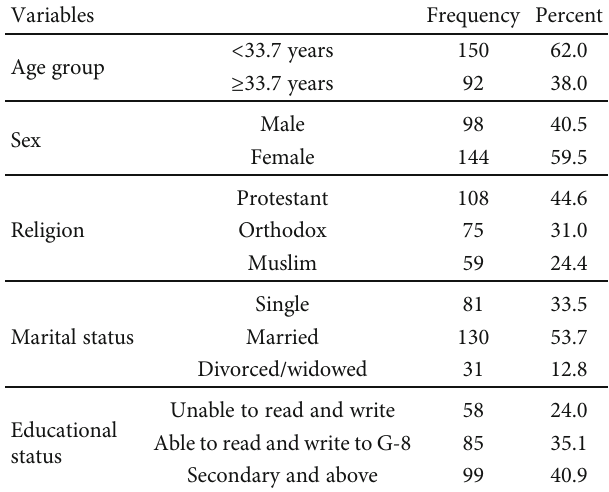
Table 1: Sociodemographic characteristics of type one diabetic patients at MKRH,